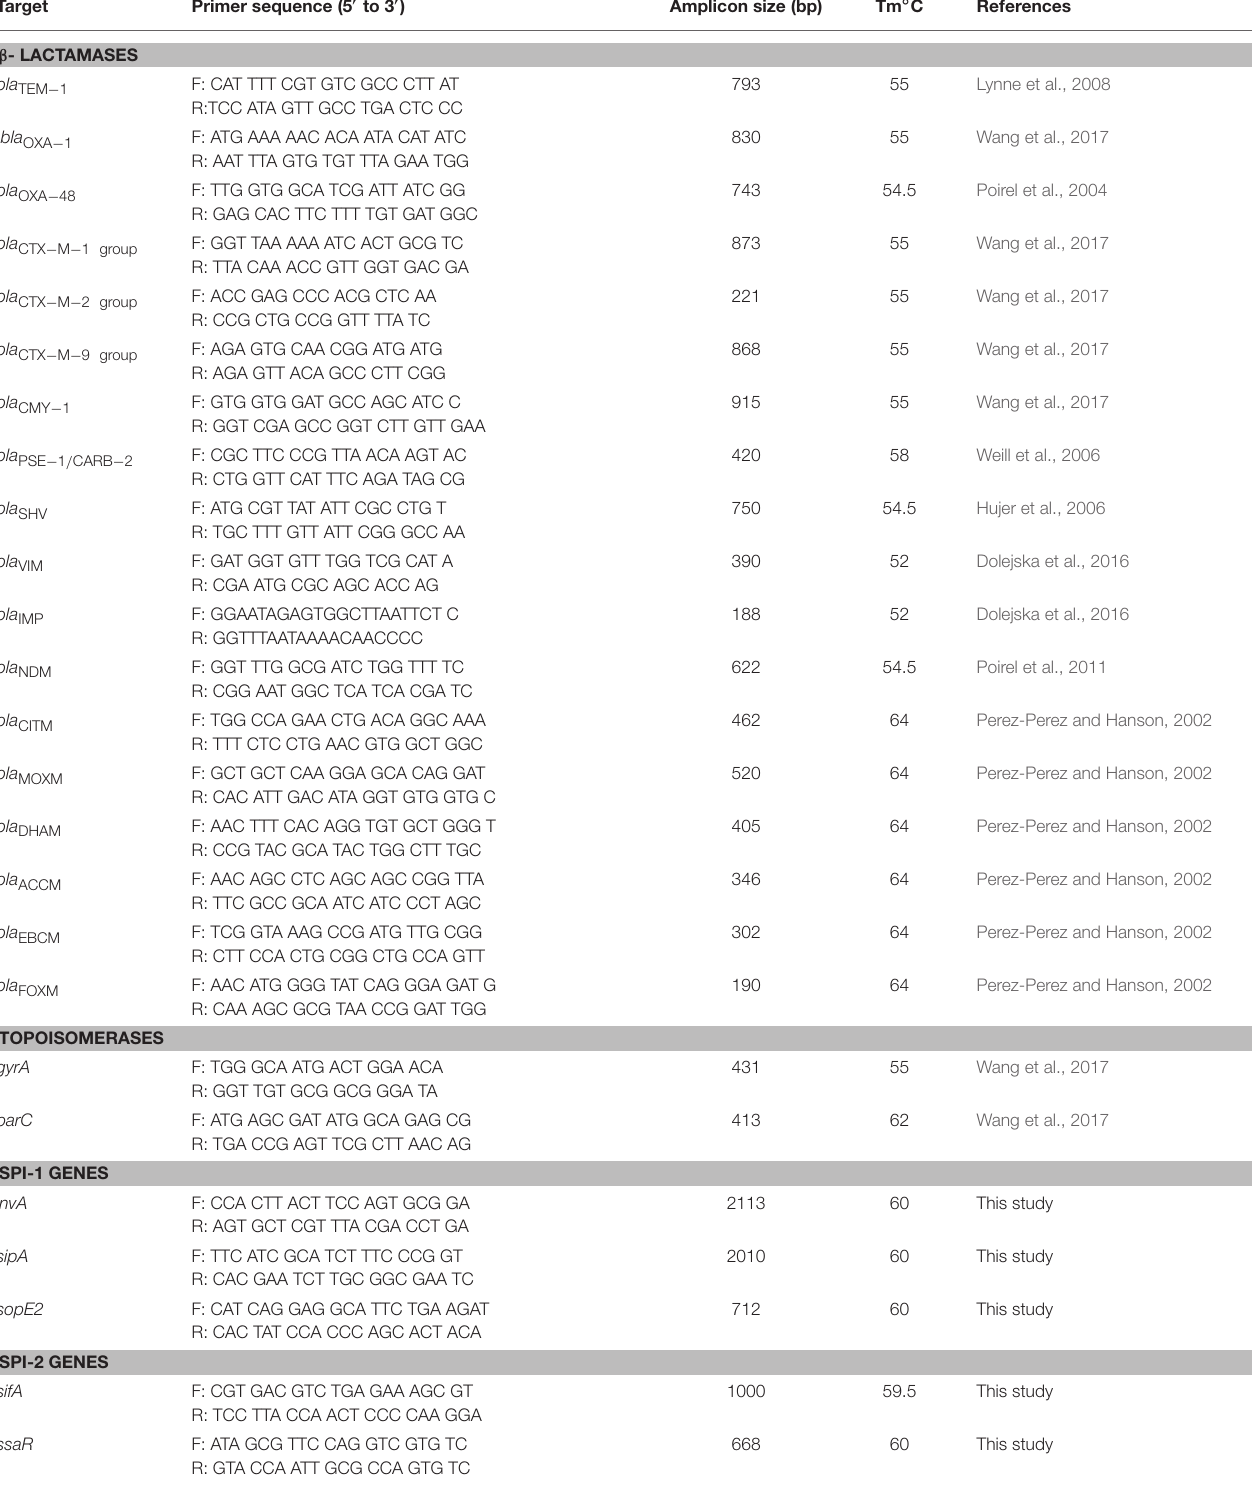
TABLE 1 | Primers used in this study to detect antimicrobial resistance determinants and SPI genes.